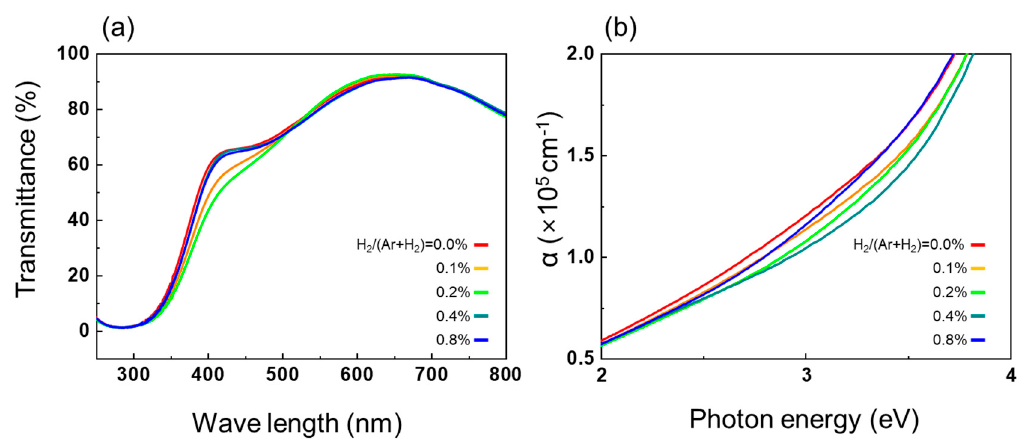
Figure 5. Optical properties of In − Zn − O thin films with various hydrogen flow rates. ( a ) transmittance and ( b ) absorption coefficients ( α ) calculated from the measured transmittance and reflectance spectra, respectively.